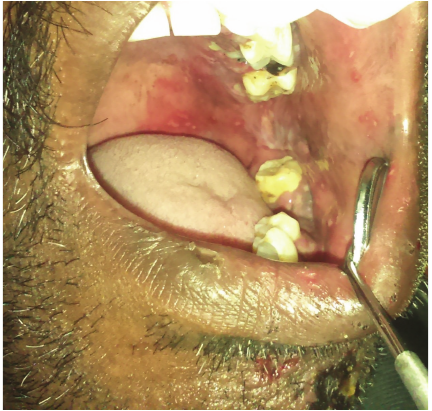
Figure 3: Vesicles and erosions seen in the buccal mucosa, mandibular alveolar mucosa, and